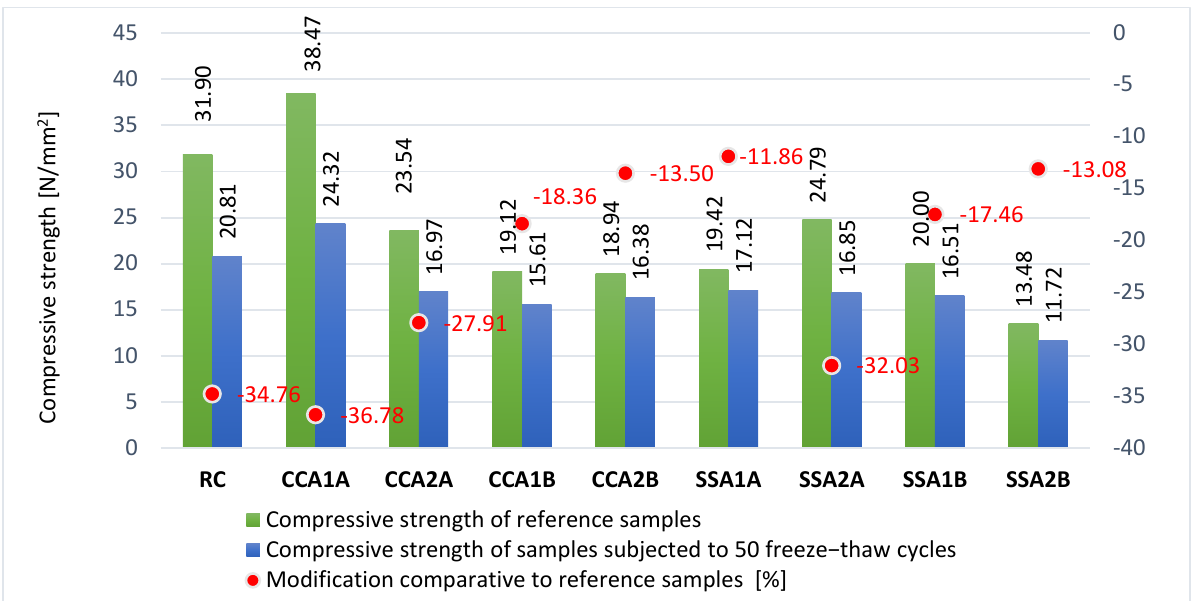
Figure 9. Compressive strength variation after 50 freeze–thaw cycles [%].